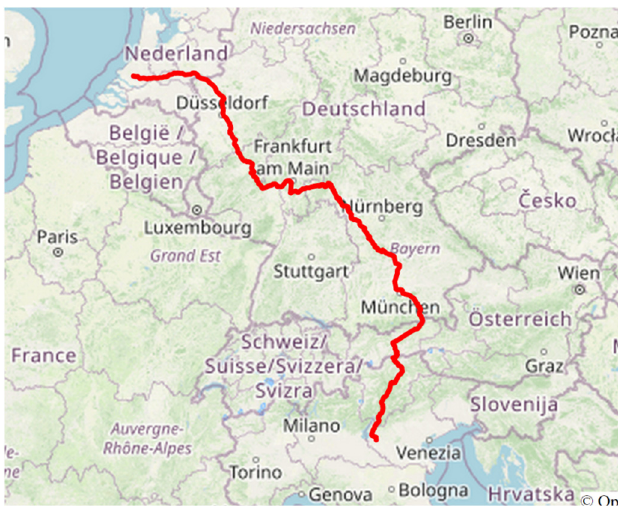
Figure 12. Example of GPS track data during field experiments.